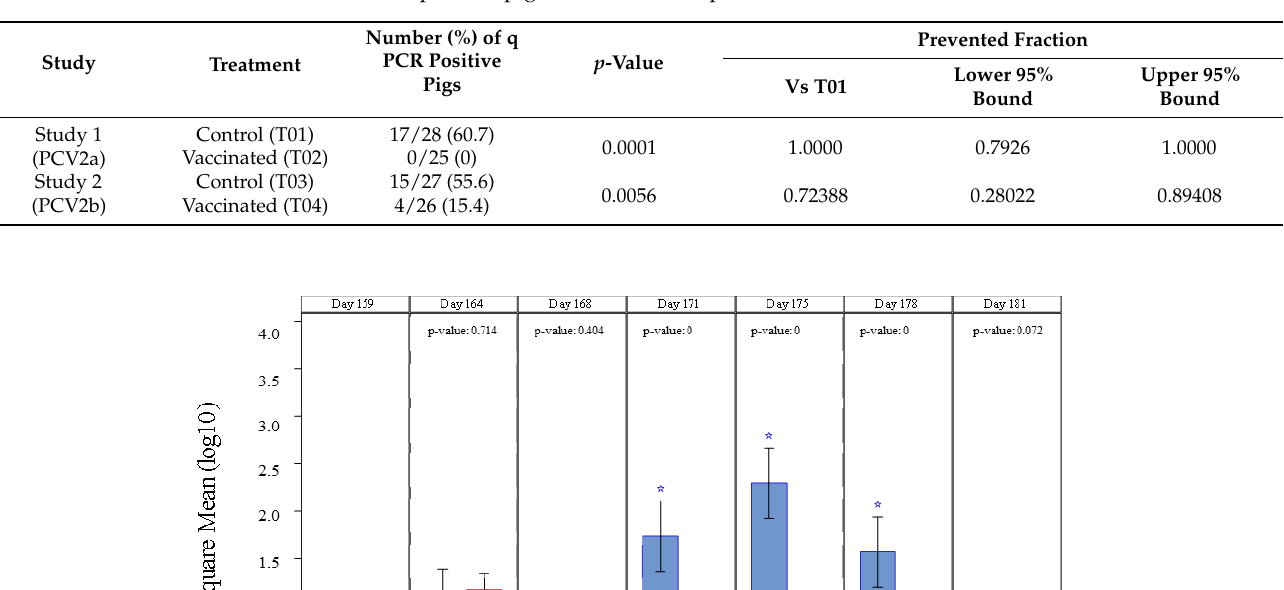
Table 2. Percent of ever positive pigs and estimate of prevented fraction for PCV2 viremia.